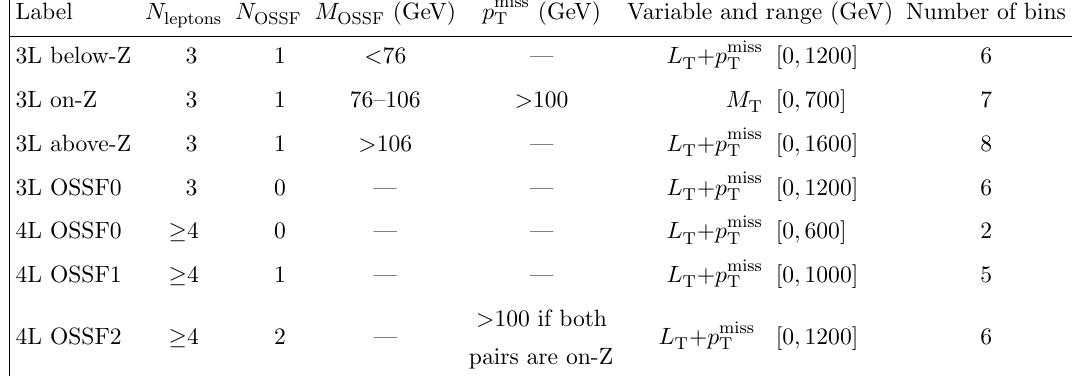
Table 1 . Multilepton signal region de(cid:12)nitions for the type-III seesaw signal model. All events containing a same-(cid:13)avor lepton pair with invariant mass below 12 GeV are removed in the 3L and 4L event categories. Furthermore, 3L events containing an OSSF lepton pair with mass below 76 GeV when the trilepton mass is within a Z boson mass window (91 (cid:6) 15 GeV) are also rejected. The last L + p miss or M bin in each signal region contains the over(cid:13)ow T T T